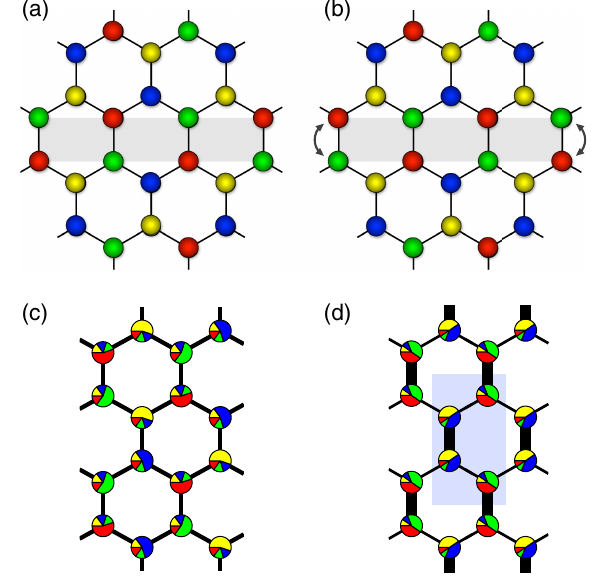
FIG. 3. Examples of states obtained with LFWT (a),(b) and iPEPS for small bond dimension D (c),(d). (a) Most symmetric configuration. (b) Configuration obtained from the most sym- metric one by exchanging colors on a stripe. (c) Color-ordered state with one dominant color per site, obtained with a 4 (cid:2) 4 unit cell and a bond dimension D ¼ 6 . (d) Dimer-Ne´el ordered state obtained with a 2 (cid:2) 2 unit cell (shaded in blue) and D ¼ 6 . Both the color order and the dimerization vanish in the infinite- D limit. The pie charts show the local color density on each site, and the thickness of a bond is proportional to the square of the energy on the corresponding bond.